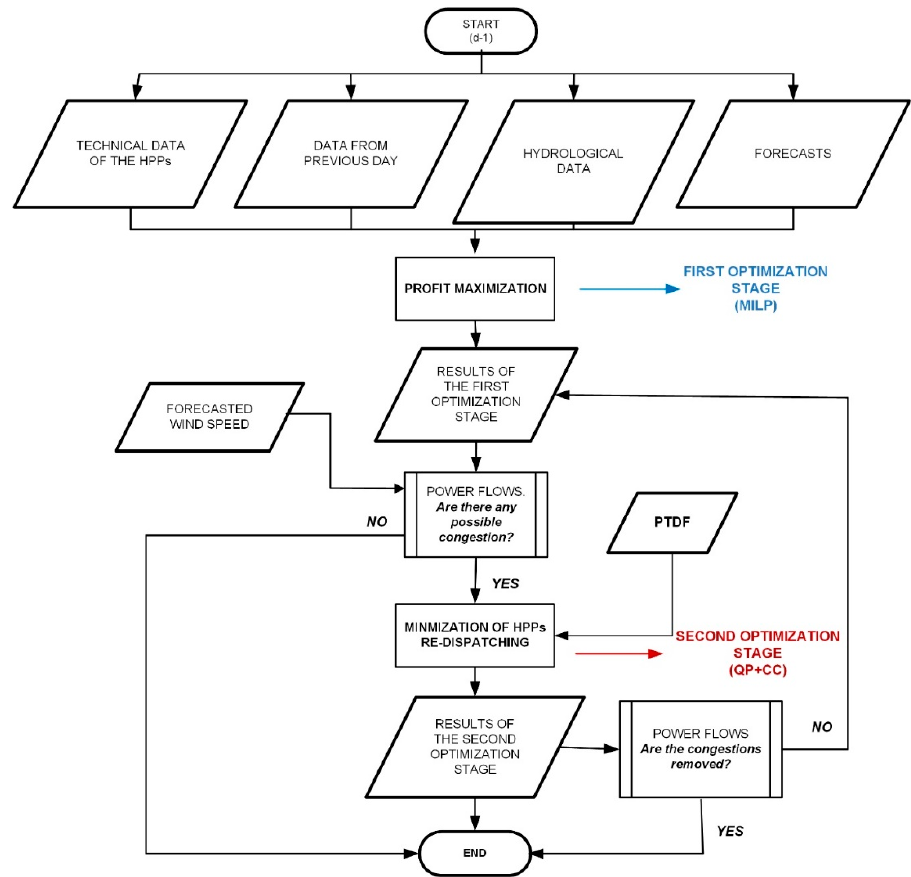
Figure 6. Block diagram of the developed two-stage optimization method.